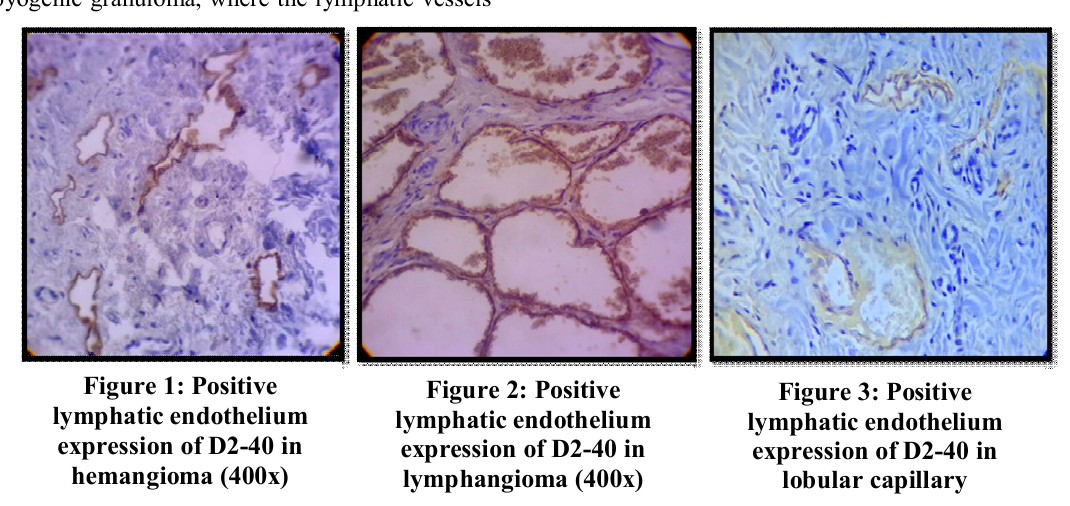
Figure 1: Positive lymphatic endothelium